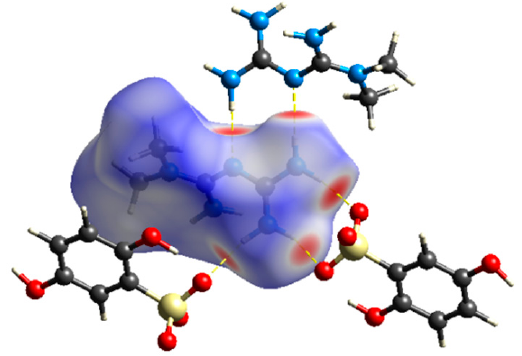
Figure 12. The Hirshfeld surface marked with hydrogen bonding interactions of MET–DBS.